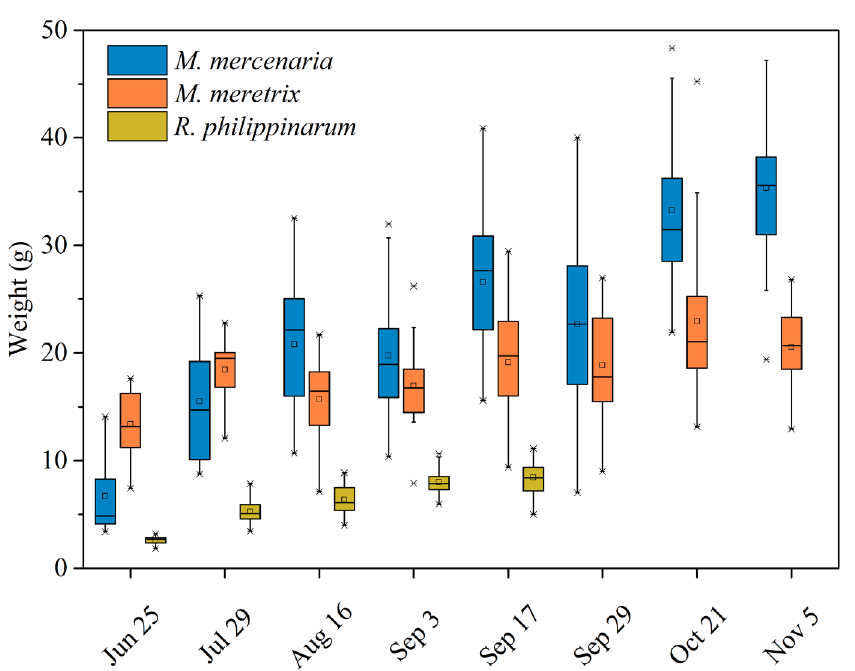
Figure 2. The weight variation of M. mercenaria , M. meretrix , and R.